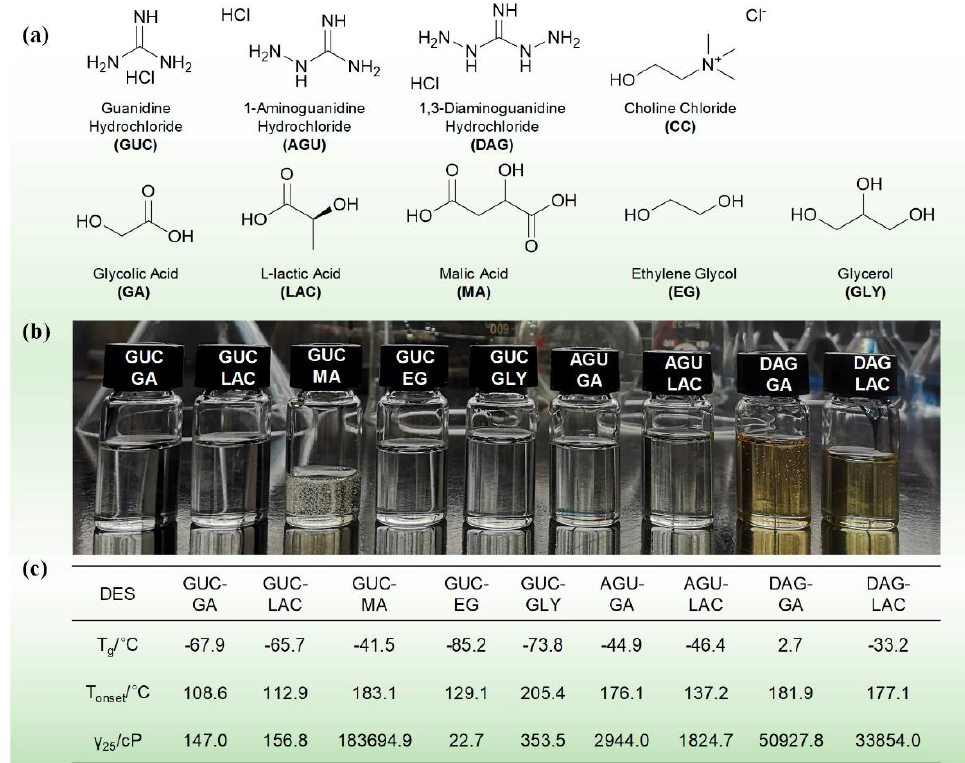
Figure 9. ( a ) Chemical structures of HBA (hydrogen-bond acceptor) and HBD (hydrogen-bond do- nor) molecules used in this work, ( b ) photograph of prepared DESs, and ( c ) glass transition temper- ature (T g , °C), onset decomposition temperature (T onset, °C ), and viscosity (γ) at 25 °C of guanidine - based DESs. “ Reprinted (adapted) with permission from Liu, C.; Yan, Q.; Zhang, X.; Lei, L.; Xiao, C.